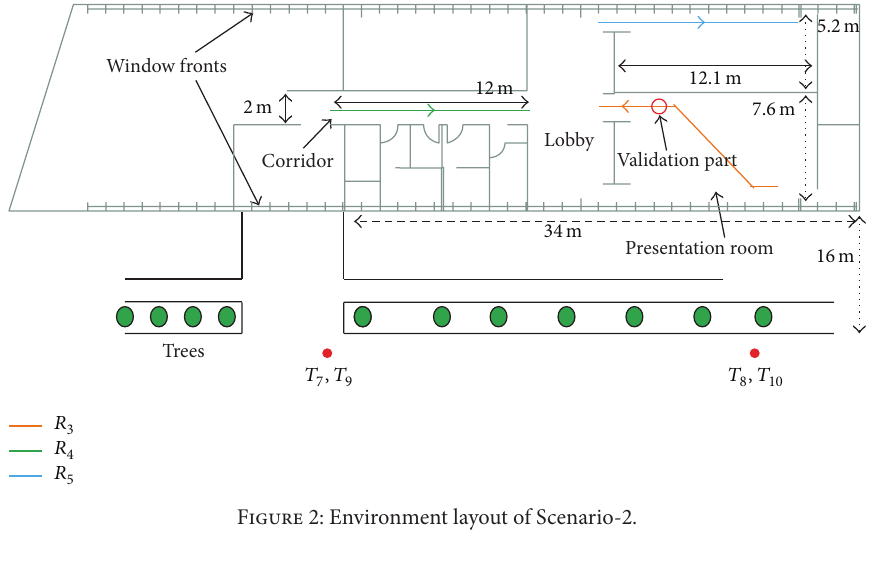
Figure 2: Environment layout of Scenario-2.